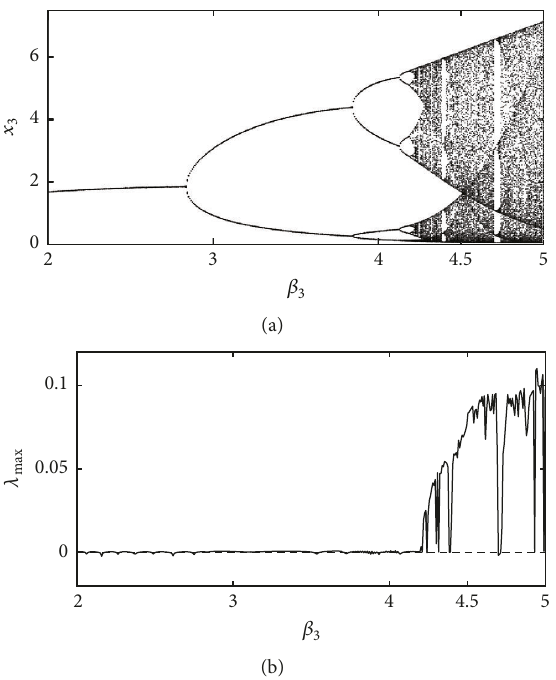
Figure 3: Bifurcation diagram of R¨ossler system for 𝛽 1 = 𝛽 2 = 0.2 using (a) Poincar´e map and (b) largest Lyapunov exponent.